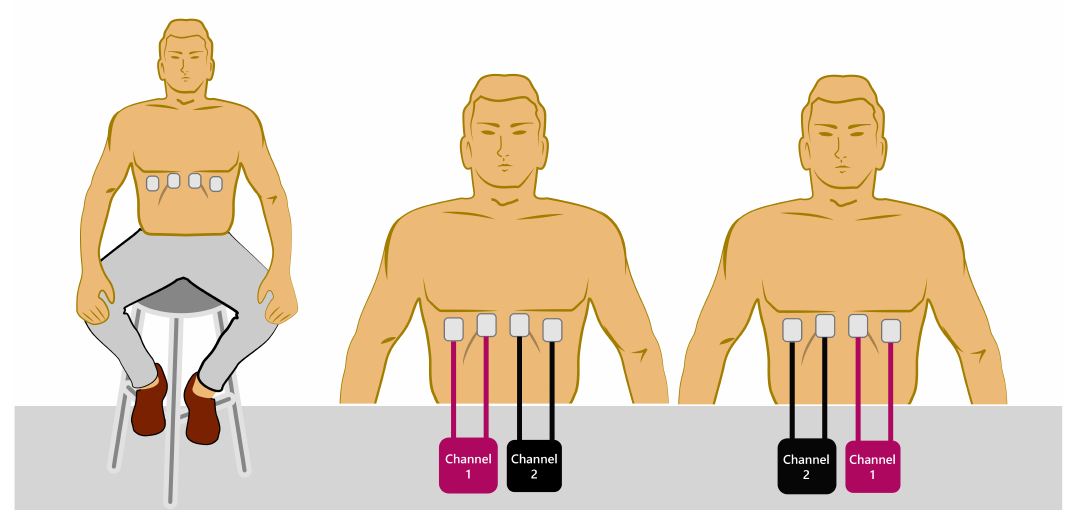
Figure 7. Volunteer position and channel configurations for TEB system measurements [36].